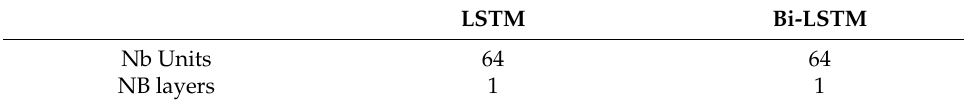
Table 5. Classifiers’